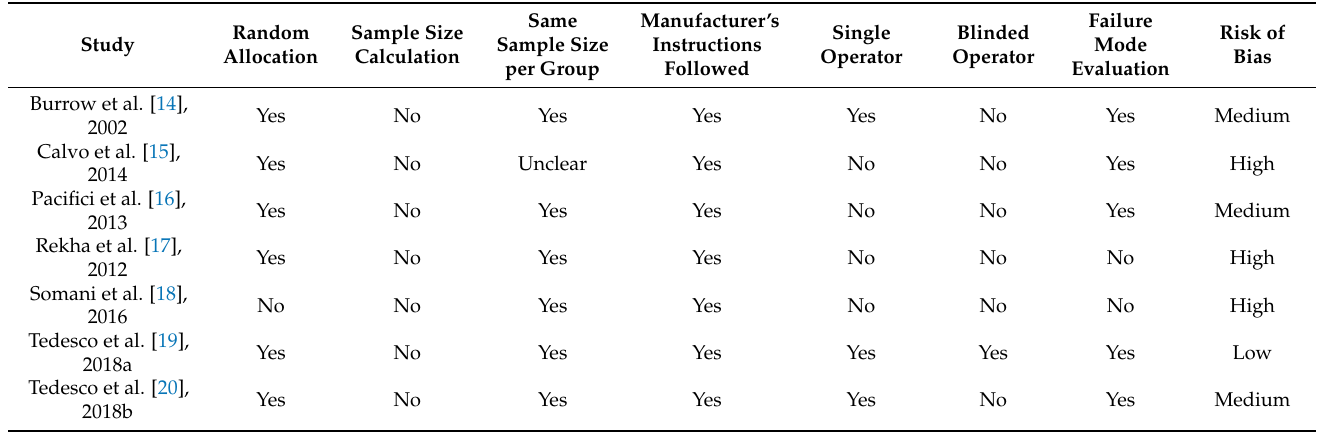
Figure 3. Forest plot for the meta-analysis of C-GIC and RM-GIC long-term bond strength in primary enamel and dentin. Table 2. Risk of bias.